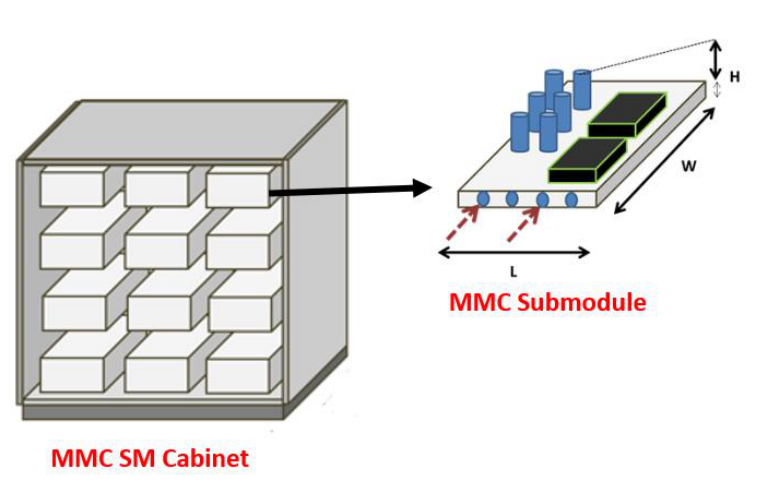
Figure 5. MMC submodule arrangement in a